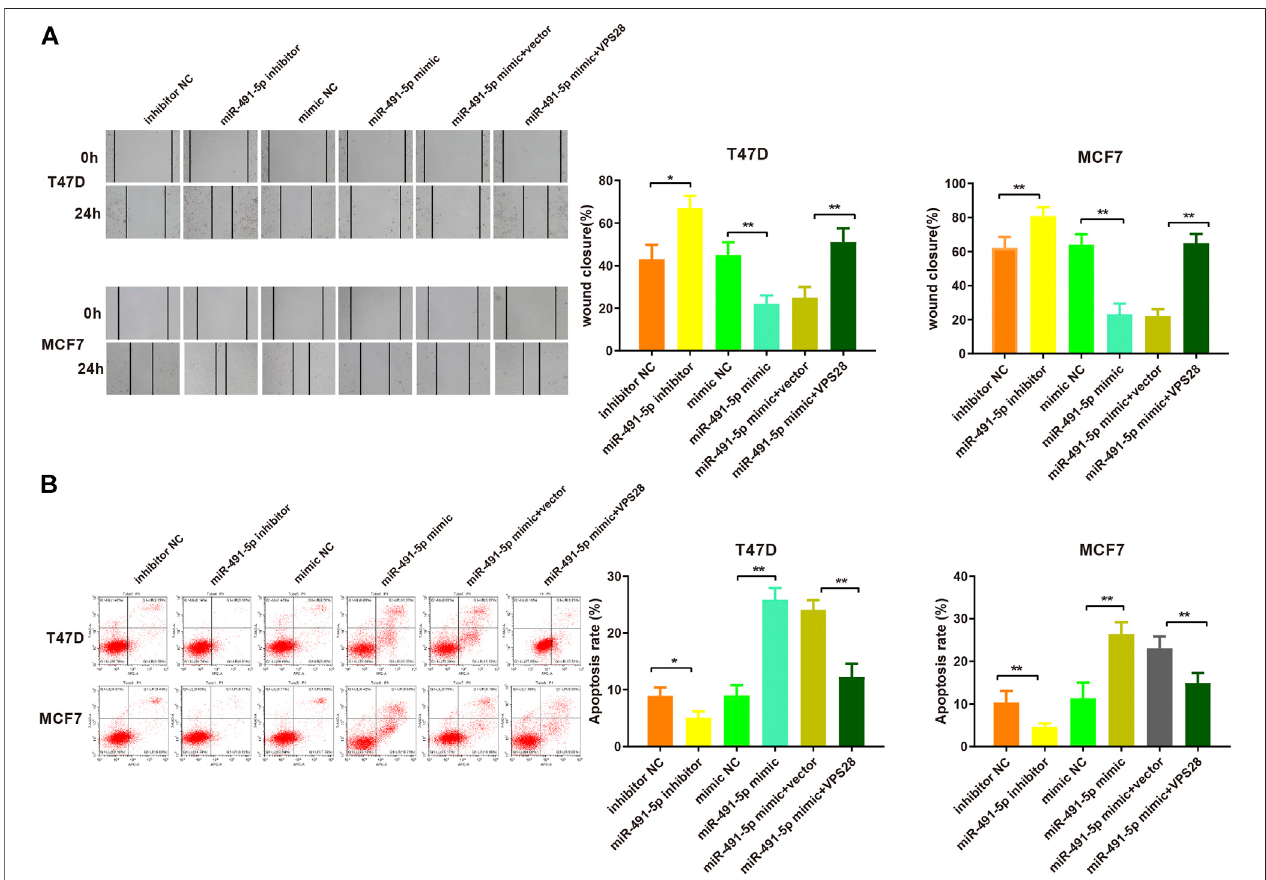
FIGURE 8 | Micro RNA-491-5p inhibits the invasiveness and apoptosis of breast cancer cells by regulating VPS28. Cell invasiveness was measured using the transwell assay (A) , while cell apoptosis was determined by fl ow cytometry (B) . ** p < 0.01, *** p < 0.001, n (cid:1) 3.